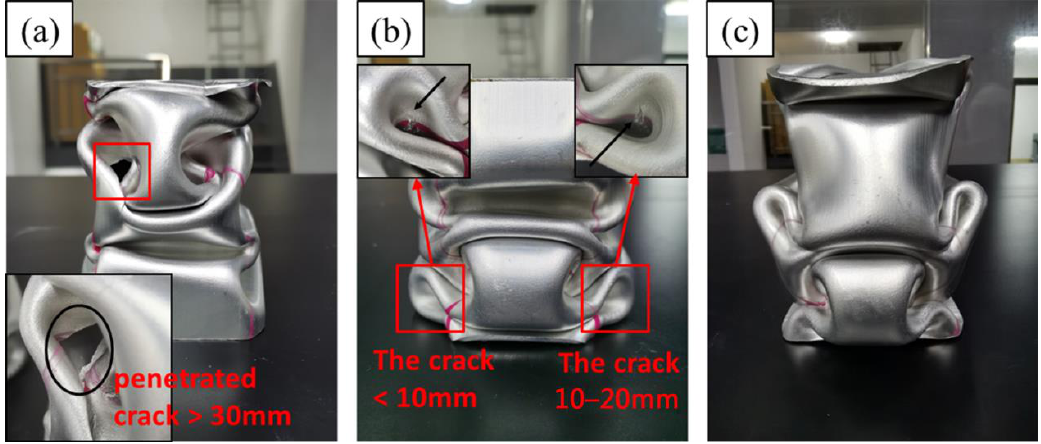
Figure 2. Folds and cracks formed in specimens after crushing test: ( a ) A1, ( b ) A3 and ( c ) A6. Table 3. Number of cracks in specimens after crushing test and grade of crushing performance.